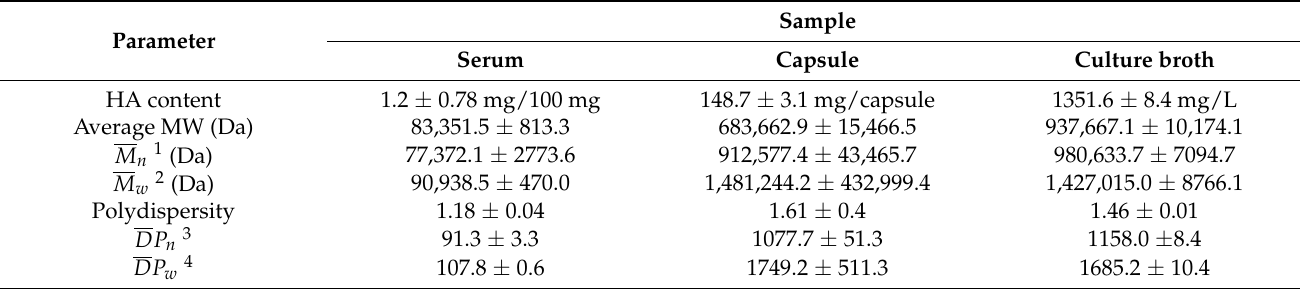
Table 4. Concentration and molecular weight distribution of HA in commercial samples and culture broth analyzed by